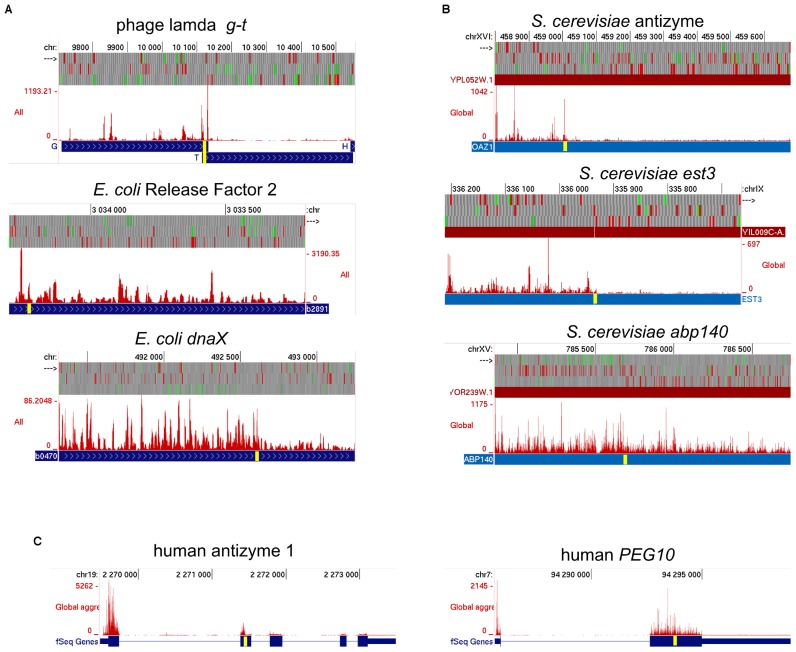
GWIPS-viz (816) screenshots of profiles of ribosome footprint densities. Expression of the selected genes involves ribosomal frameshifting from (A) bacteria, (B) yeast and (C) humans. Blue bars at the bottom represent annotation of protein coding genes according to the corresponding genomes (A and B) and RefSeq (C) with yellow boxes indicating positions of frameshifting sites. The density of ribosome footprints is shown as red columns corresponding to inferred positions of the A-sites. The top plots (A and B) show ORF organisation in genomes (green ticks are for ATG and red for stop codons). For more details on notations used see GWIPS-viz browser at http://gwips.ucc.ie